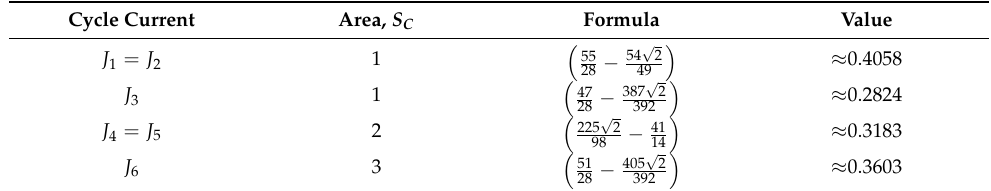
Table 3. Cycle currents, J C , in anthracene calculated using Equation (7) with areas S C , and values A C from Table 2. Currents are given in units of the ring current in benzene. Cycles are labelled as shown in Table